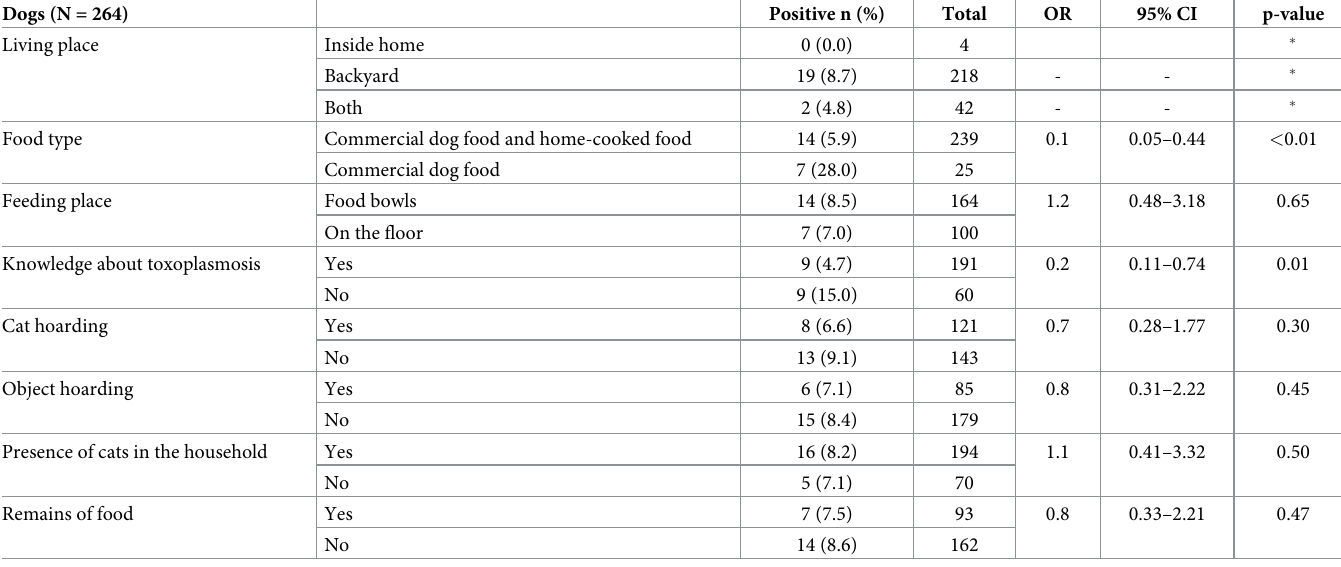
Table 1. Bivariate analysis of epidemiological data and seropositivity for anti- T . gondii in dogs from individuals with animal hoarding disorder (AHD) in Curitiba, Parana´, Brazil. Dogs (N =